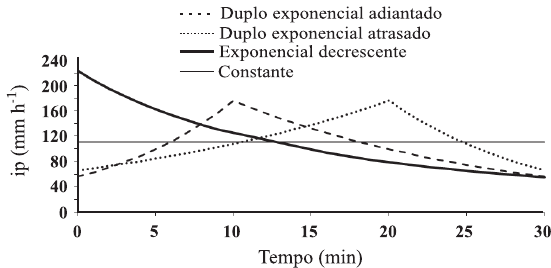
figura 2. perfis de precipitação pluvial utilizados no